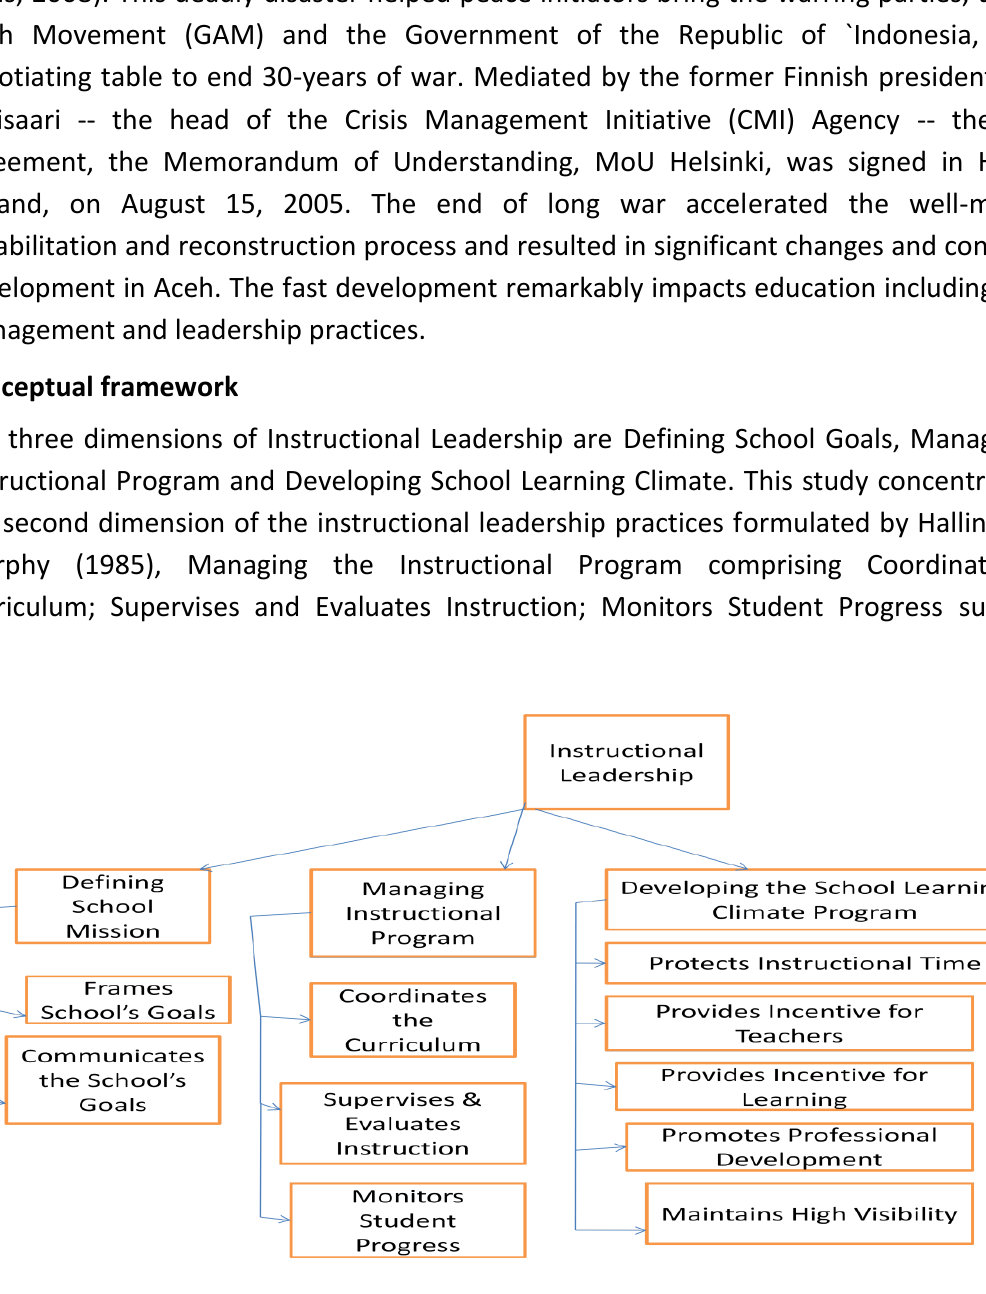
Figure 1 Conceptual Framework: Instructional Leadership Practices of the Principals of the Excellent Schools in Aceh, Indonesia. This conceptual framework is adopted from: Hallinger, P., & Murphy, J. (1985). Assessing the instructional leadership behavior of principals